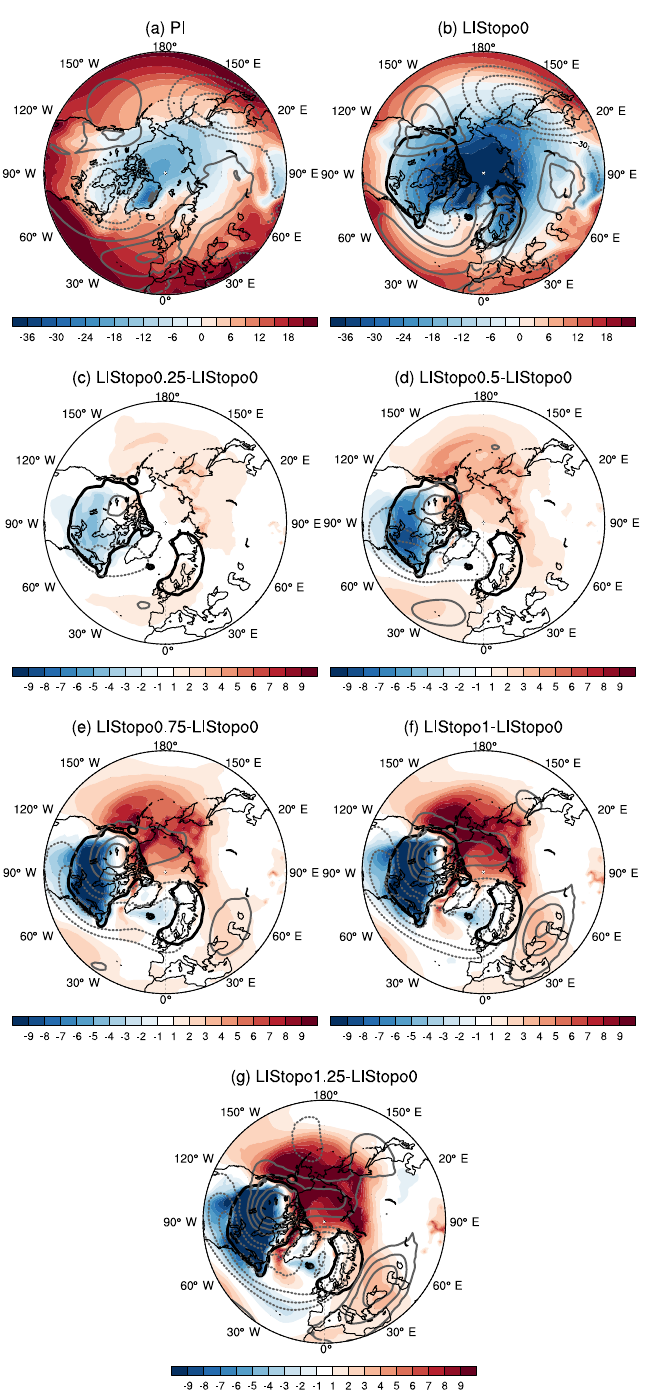
Figure 1. Annual-mean surface temperature ( ◦ C) (colored shading) and eddy geopotential height at 500hPa (gray contours) in (a) the PI and (b) the LIStopo0 simulations. Panels (c–g) show the influence of the LIS elevation on the surface temperature with respect to LIStopo0 in the (c) LIStopo0.25, (d) LIStopo0.5, (e) LIStopo0.75, (f) LIStopo1, and (g) LIStopo1.25 simulations, respectively. The contour interval of the eddy geopotential height is 30m (zero contour is omitted) and negative values are dotted. The black contours outline the LIS and FIS extents in the LGM